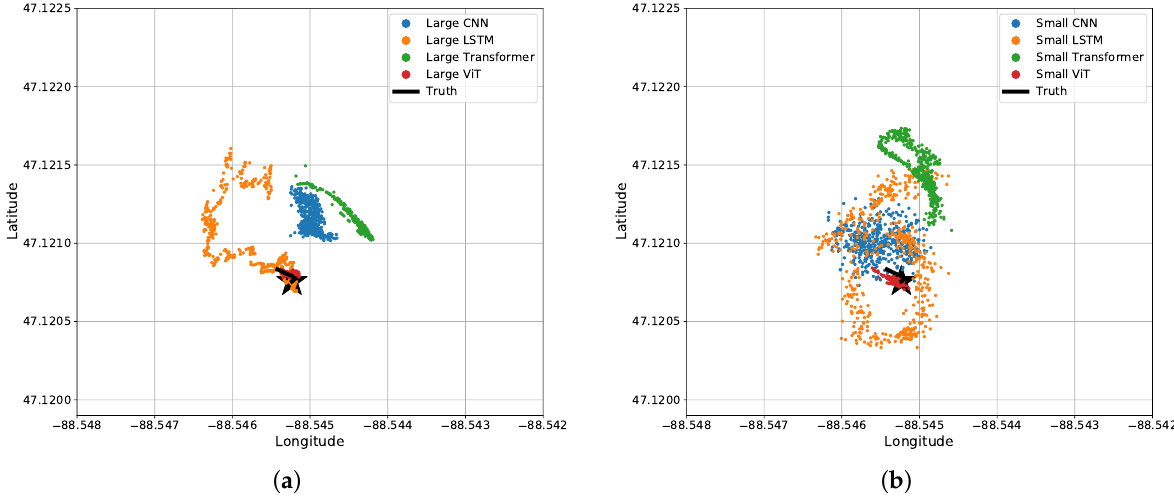
Figure 13. Bird’s eye view of results for the four different ( a ) large regression algorithms and ( b ) small regression algorithms when the acoustic source is stationary for 25